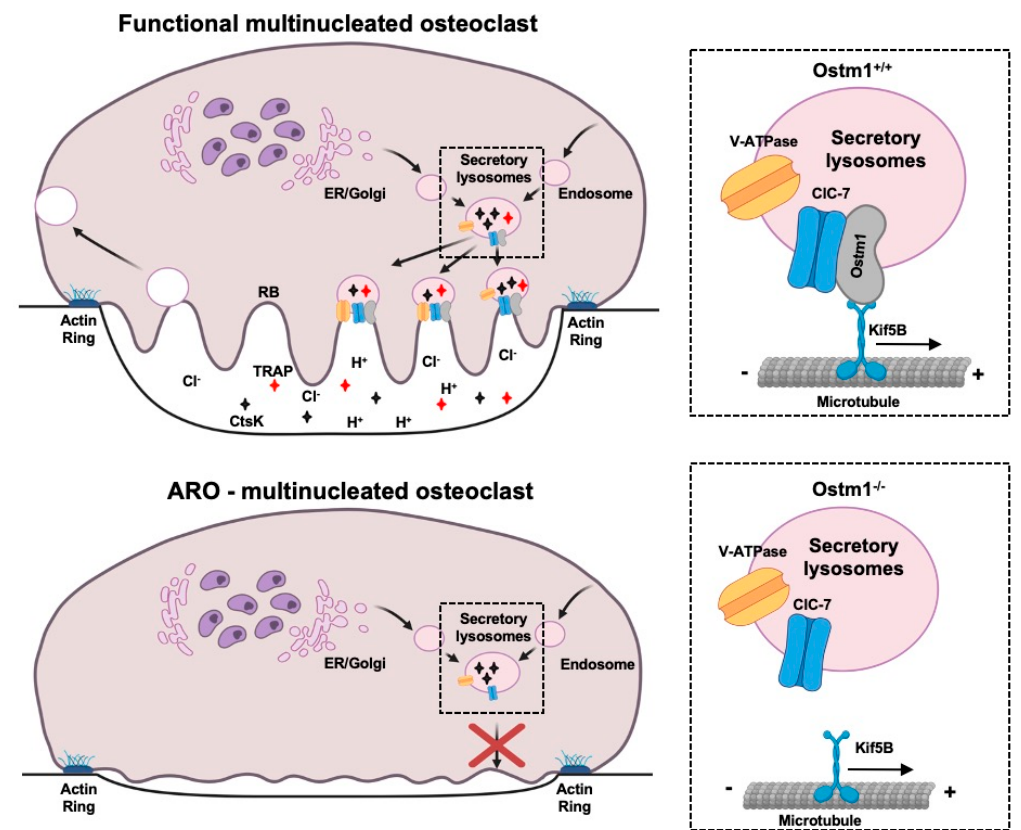
Figure 3. Proposed working model of Ostm1-mediated osteoclast dysfunction leading to autosomal recessive osteopetrosis. RB: Ruffled border; ER: Endoplasmic Reticulum In ARO osteoclast, impaired secretory lysosome trafficking results in lack of ruffled border formation and ineffective bone matrix resorption.